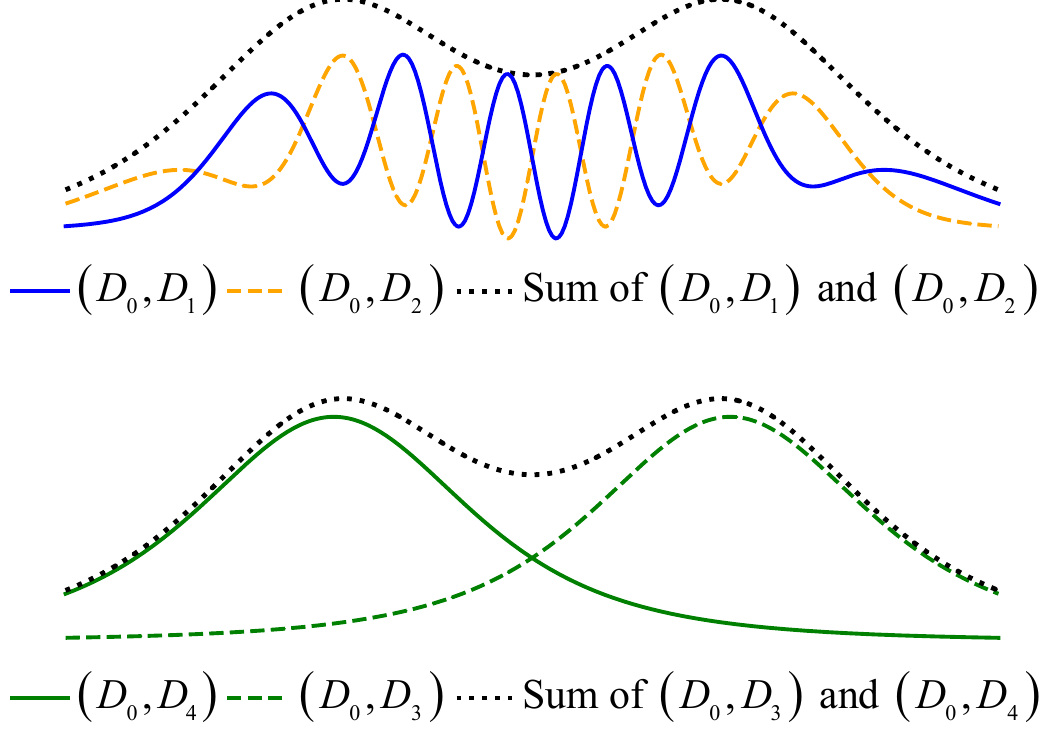
Figure 3: Joint detection events at detector D 0 and detectors D 1 -D 4 . The figure shows a plot of the bits of Eq. (11) . Records of D 0 and D 1 (D 2 ) show interference fringes. Conversely, records of D 0 and D 3 (D 4 ) show a clump pattern. If added together, the distribution on the screen in both cases (with and without eraser) is always two